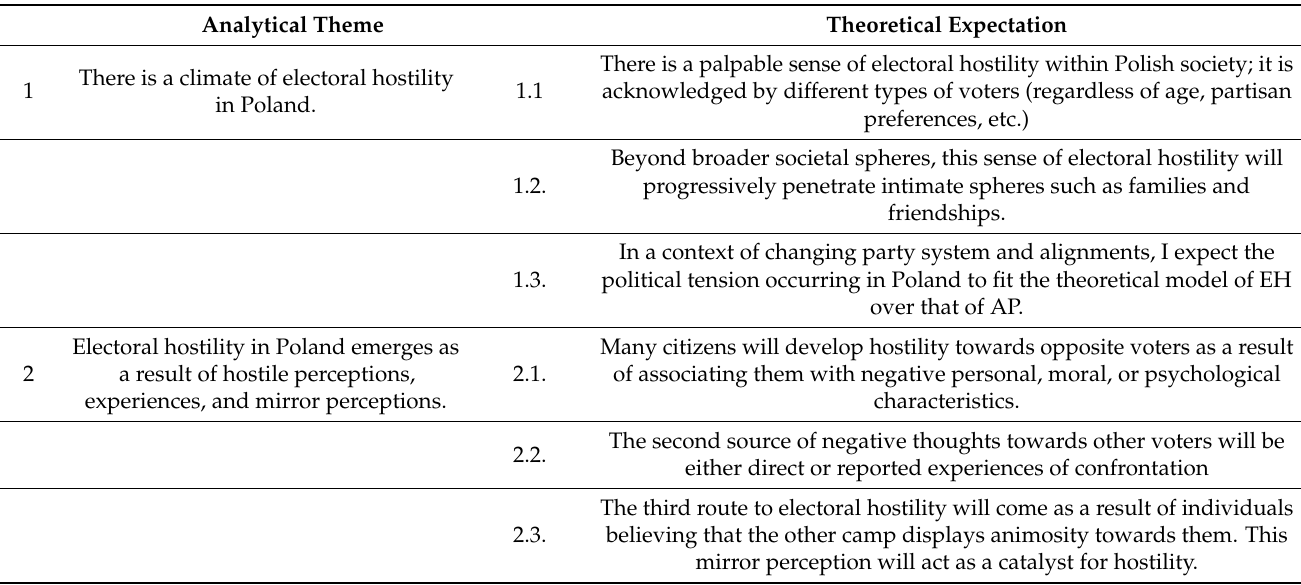
Table 1. Theoretical